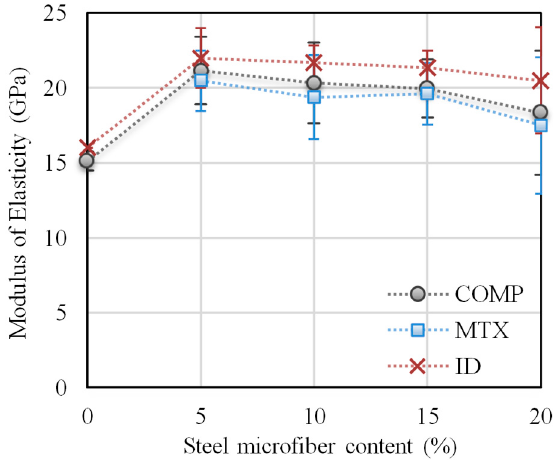
Figure 7. Modulus of elasticity of AAS mortar with different amounts of steel microfibers.